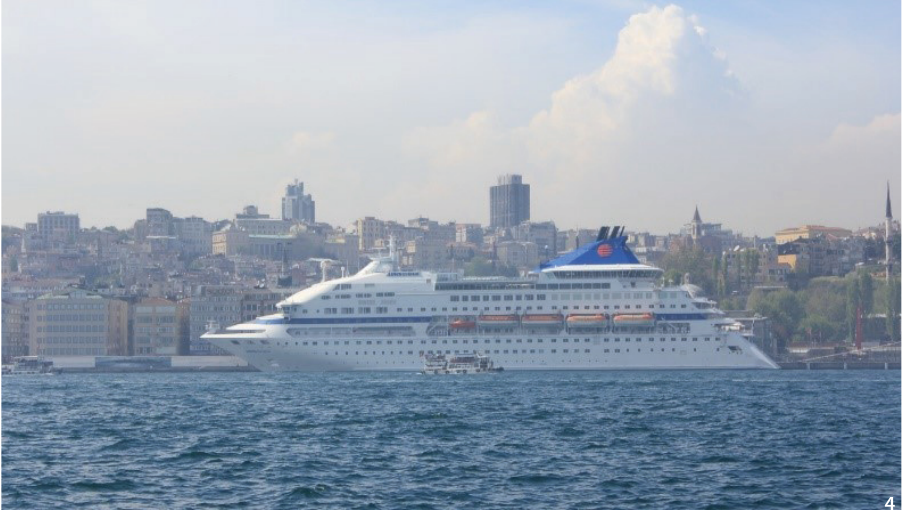
Figure 4 Culture policies: To re- shape urban areas for positioning cities on the world map